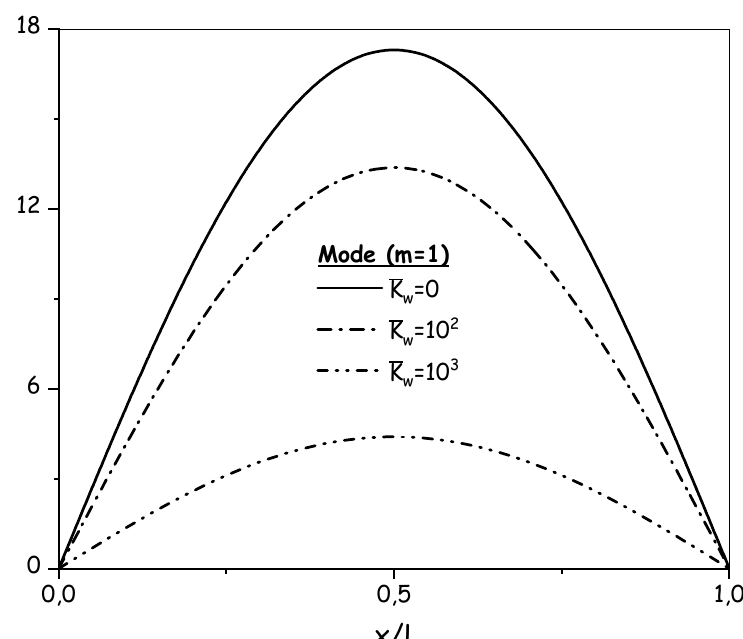
Figure 4: Variation of the nondimensional fundamental frequency Pasternak parameter